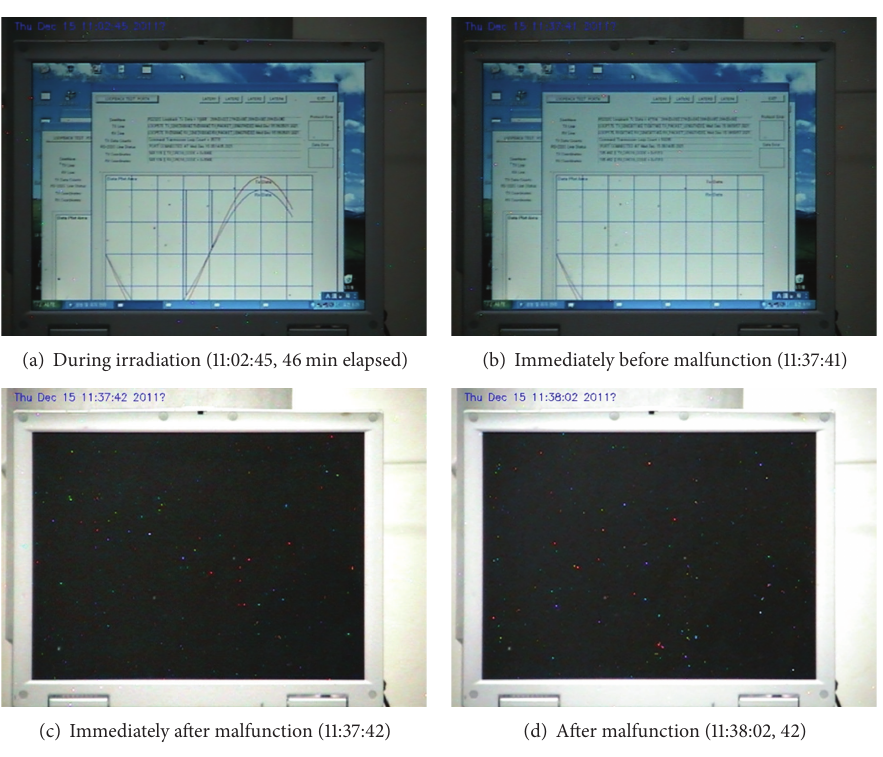
Figure 6: Menu images of the pilot application program, executed on a notebook PC under a high dose-rate gamma ray irradiation test.